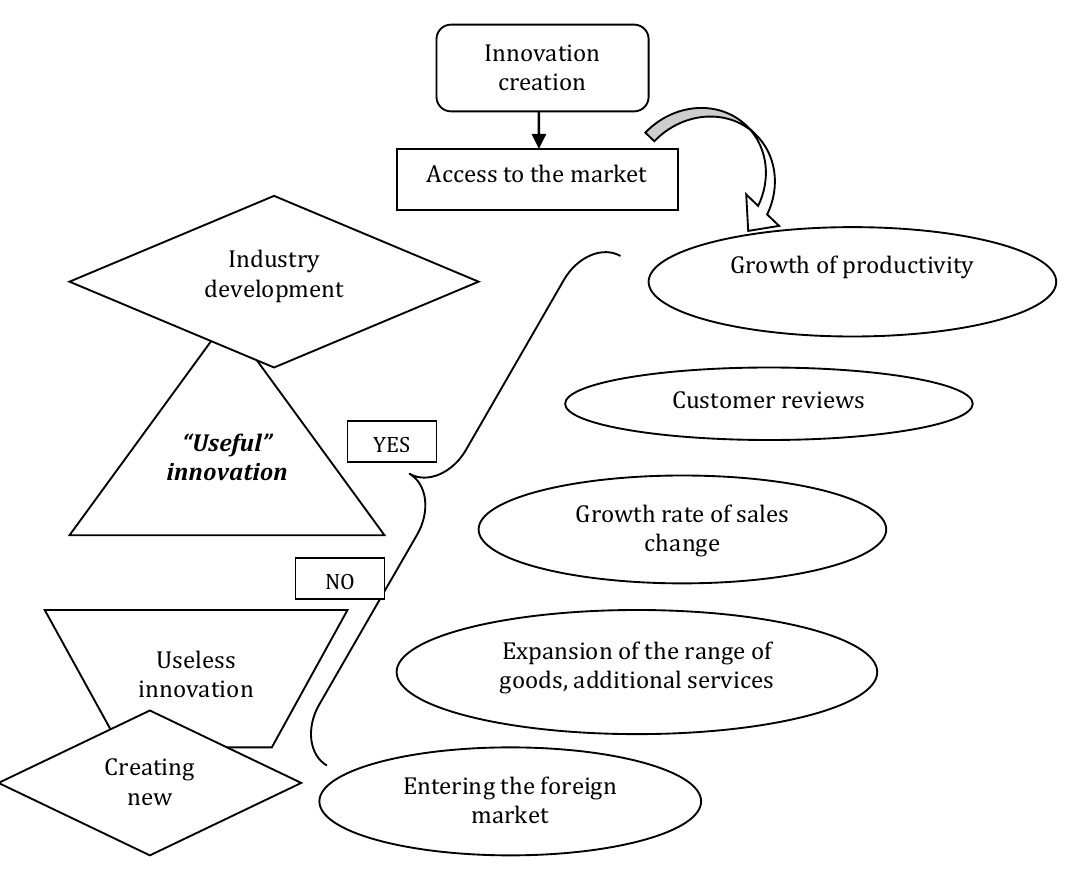
Figure2: Indicators of “useful” information